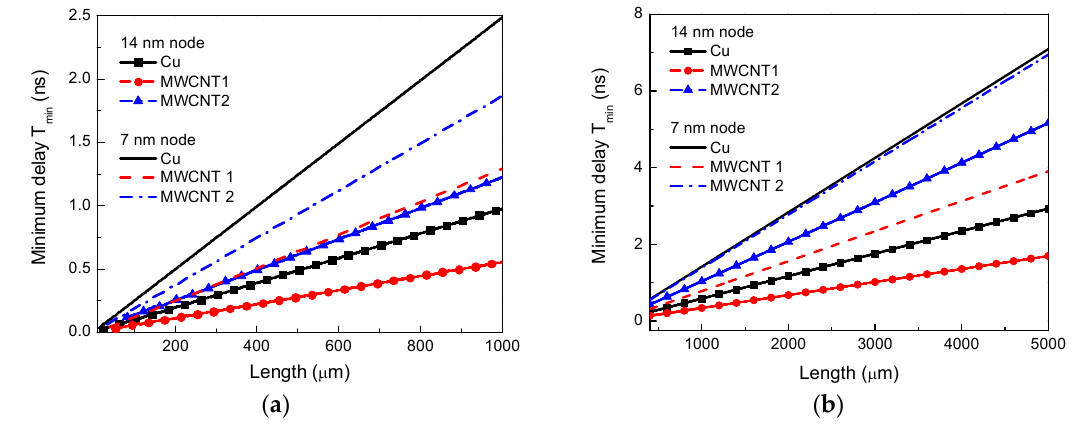
Figure 8. Optimal number of repeaters (Inset: minimum propagation delay) versus length for global-level Cu and MWCNT interconnects at the 14 nm technology node.